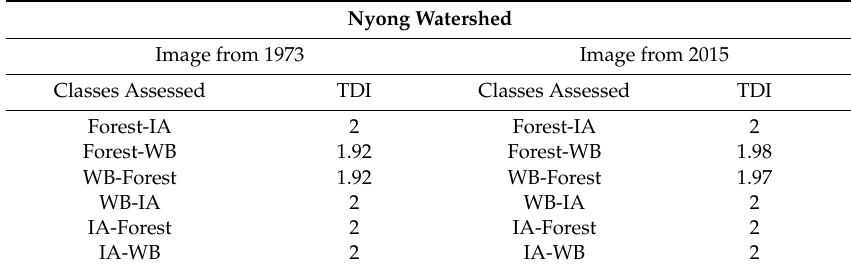
Table 2. Indices of separability between the di ff erent classes considered by watershed and by image. TDI: Transformed Divergence Index and WB: Water